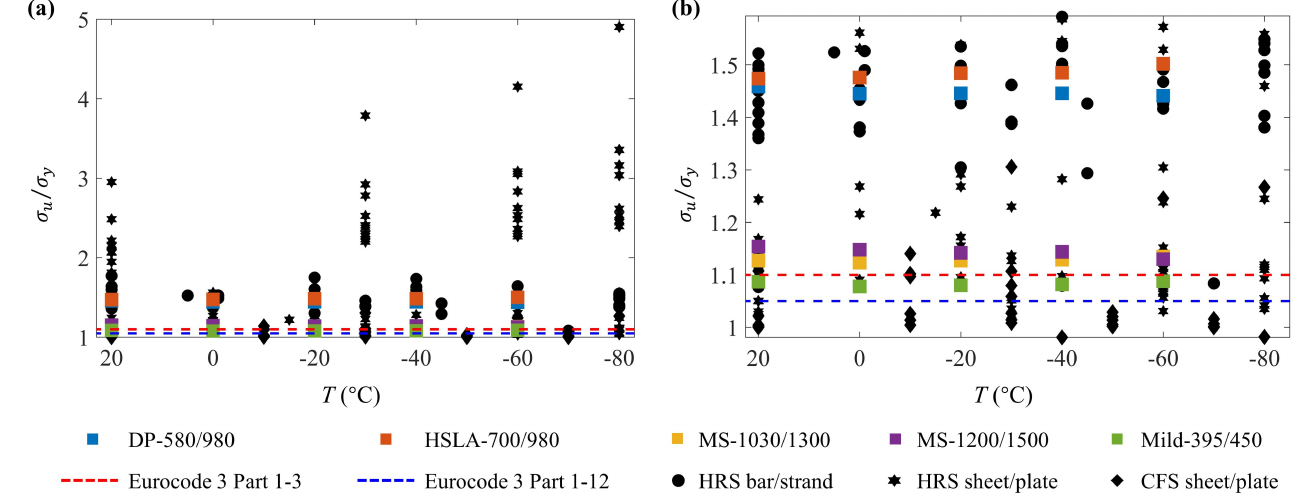
Figure 13. ( a ) The ratio between ultimate strength and yield strength for AHSS, HSLA-700/980, Mild- 395/450, and data from published experiments compared with current standard requirements [7,61]; ( b ) magnification of plot ( a ) at a normalized factor of